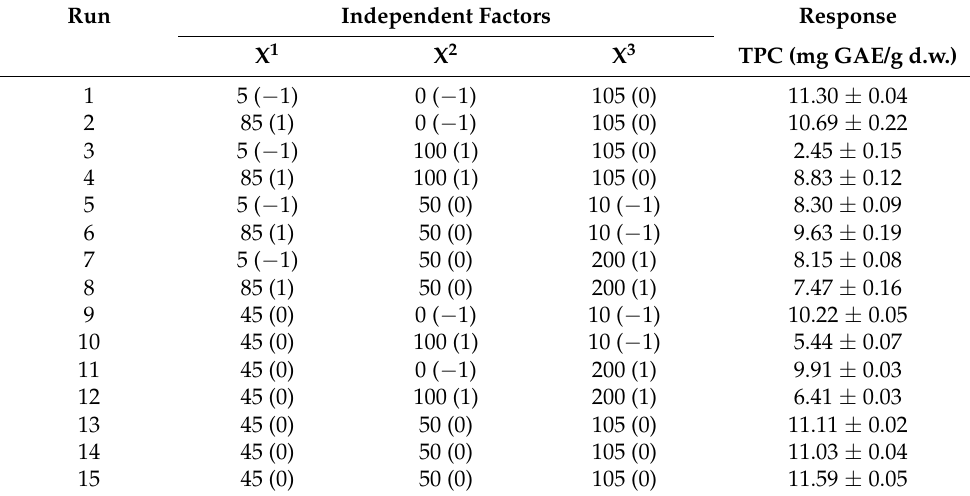
Table 4. Box–Behnken design with natural and coded values (parenthesis) of the conditions of extraction and the experimental results obtained for total phenolic content (TPC) expressed with the average and the standard deviation. Run Independent